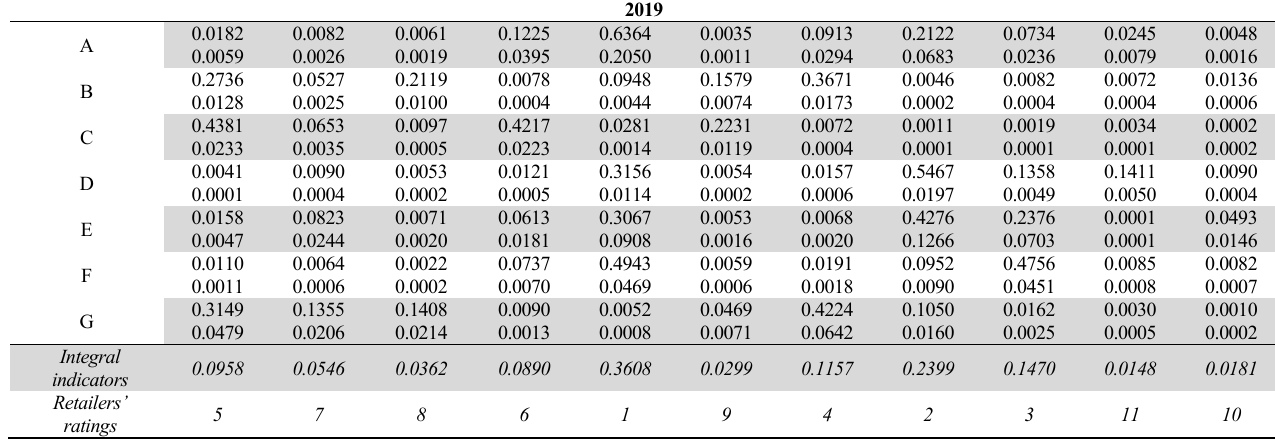
Ranking positions of the analyzed retailers by the integral competitiveness indicator in 2017-2019 (Continued)